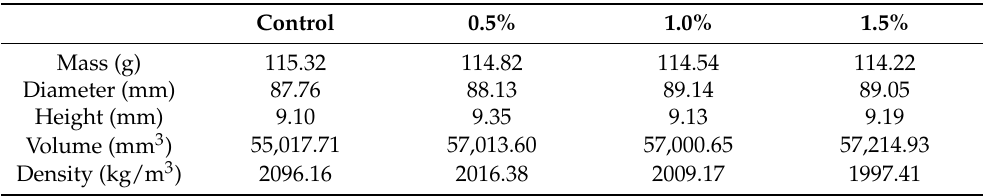
Table 4. The average basic properties of fired CB tile samples.